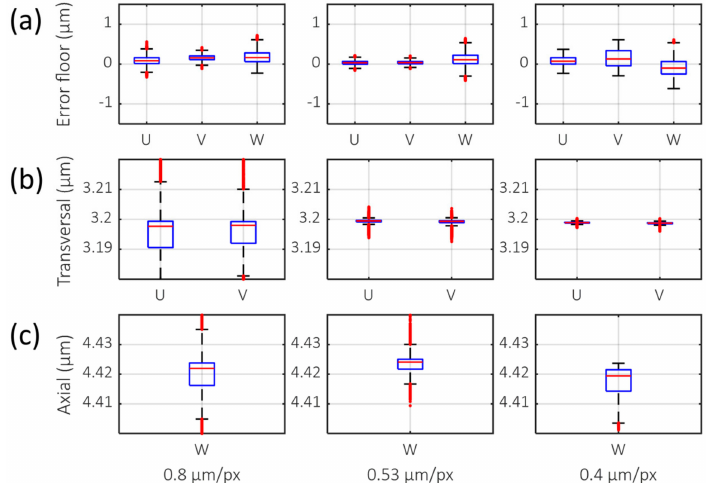
Figure 2. Cross-sectional and en face image of collagen fiber sca ff olds (2.5 mg / mL). ( a ) Schematics of imaging point spread function (PSF) size in the axial (Z) and transverse (XY) axes for GD-OCM, and SHGM with di ff erent numerical aperture (NA) (0.31, 0.5, and 0.8 NA). ( b ) OCM images of collagen sample; ( b ) SHGM images of collagen sample. The cross-sectional ZY plane image in ( c ) shows a more anisotropic, elongated image than ( b ). The field of view is 320 × 320 × 160 µ m 3 . Full-width at half maximum (FWHM) is used as the size of PSF.